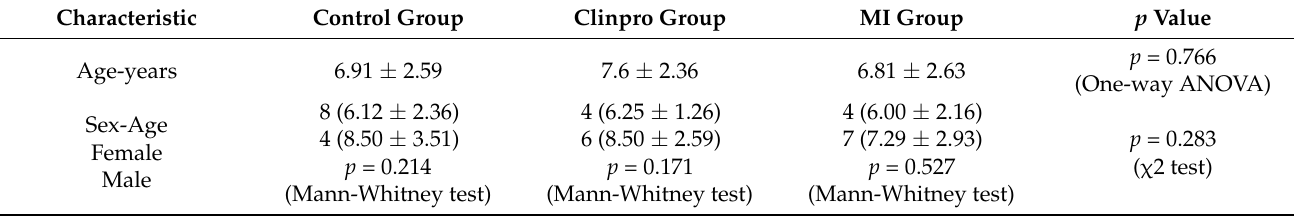
Table 2. Baseline characteristics (mean ± SD). Sex-Age: Age distribution according to sex.